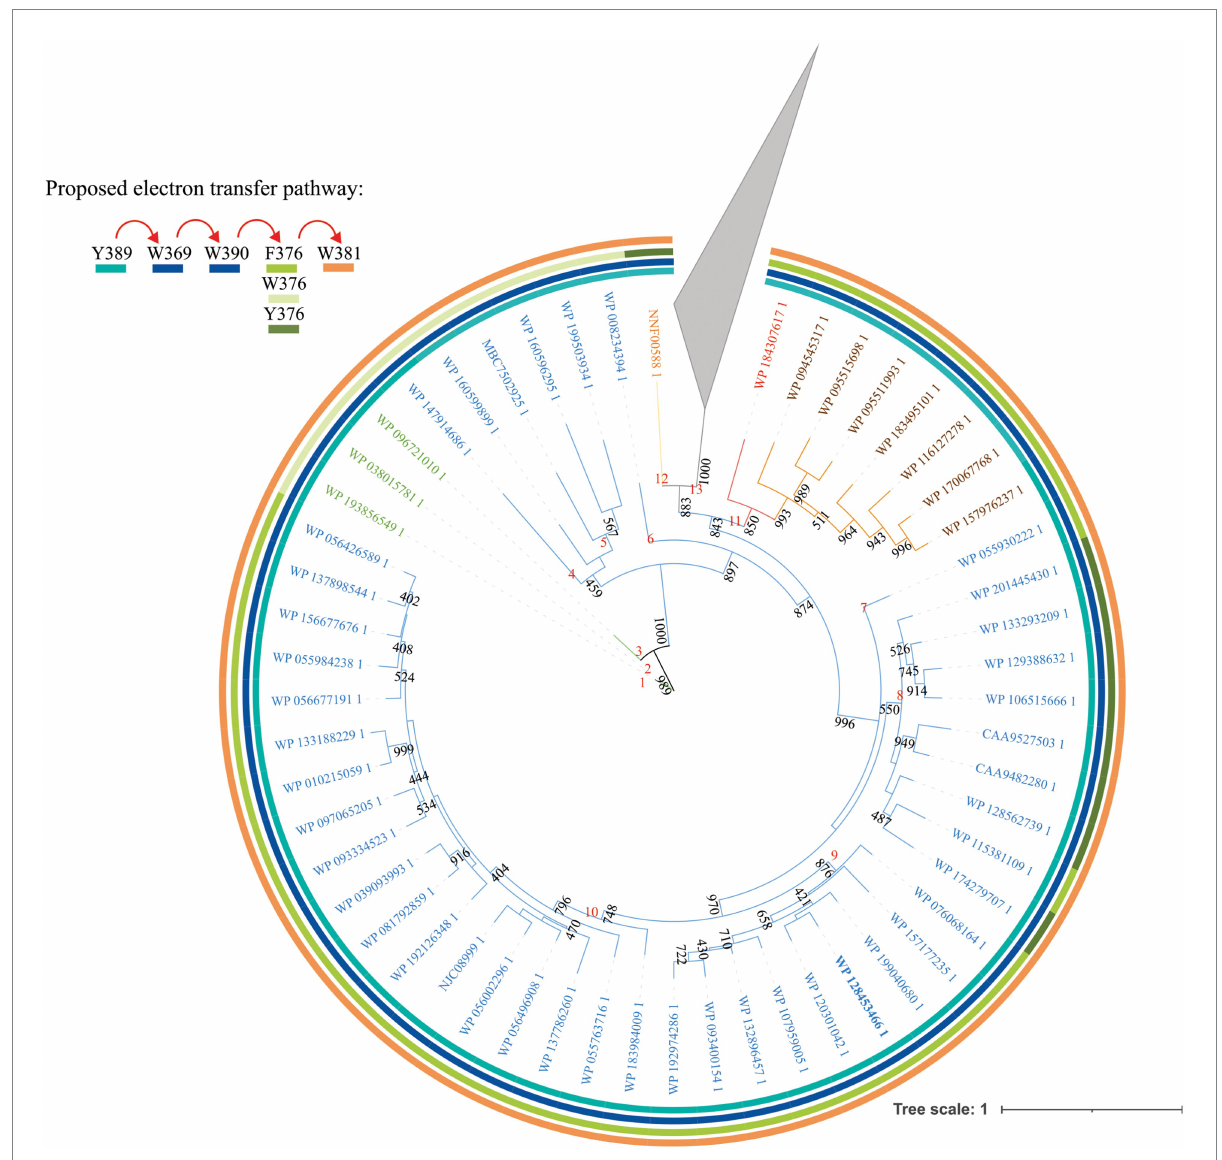
FIGURE 1 Unrooted maximum- likelihood tree of bifunctional CPD/(6-4) PHR- like proteins. Protein sequences with similarity to PhrSph98 from Sphingomonas sp. UV9 were retrieved using BLASTp and the non-redundant database. Representative sequences were used for further analysis. Evolutionary history was inferred using the maximum- likelihood method based on LG + G+ I+ F model using PHYML 3.0 (Guindon et al., 2010). The phylogenetic tree is presented as unrooted. Nonparametric bootstrapping (1,000 replicates) was used to assess tree branching support and is shown adjacent to each internal node. Those lower than 400 are not shown. Rings of different colors indicate the amino acids described in PhrSph98 to be potentially involved in electron transfer pathway: Y389- W369- W390- W376- W381. Red arrows indicate the electron flux. Text in color indicates clade of the predicted homologs of PhrSph98: green, cyanobacteria; blue, proteobacteria; red, planctomycete; brown, bacteroidete; orange, acidobacteria. The accession number of each sequence is shown. Proteins without homology in amino acids involved in PhrSph98 activity are collapsed (gray triangle). Numbers in red indicate different nodes. Full phylogenetic tree is shown in Supplementary Figure